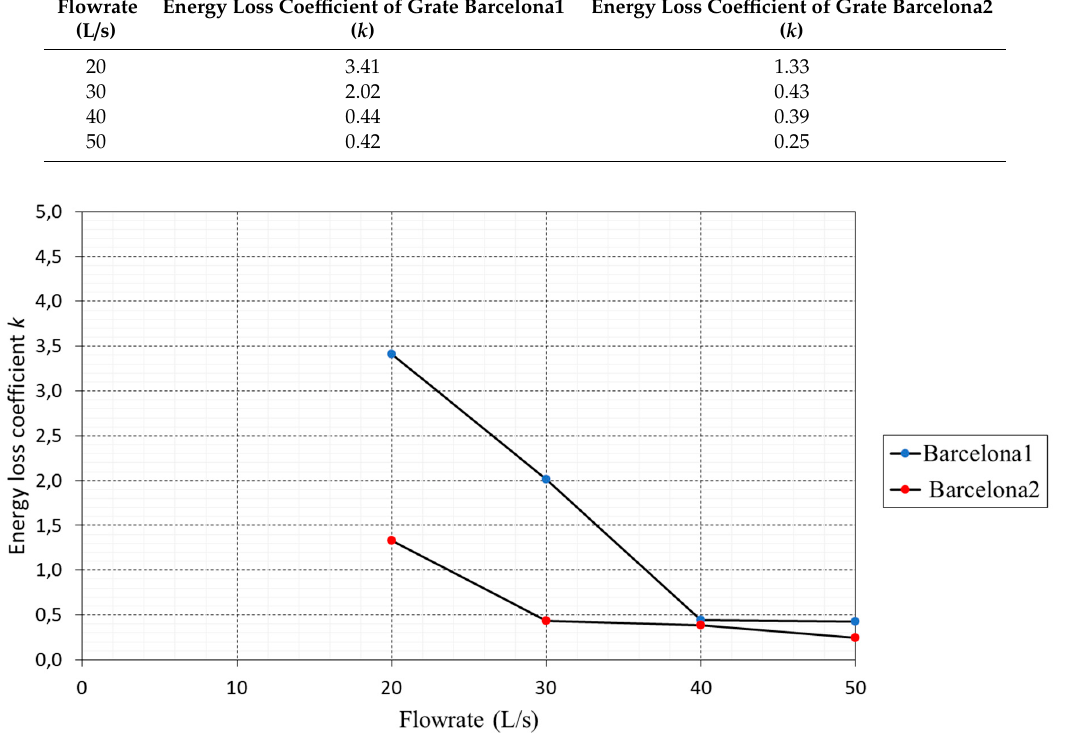
Figure 8. Mean energy loss coefficient k for the two tested grates.